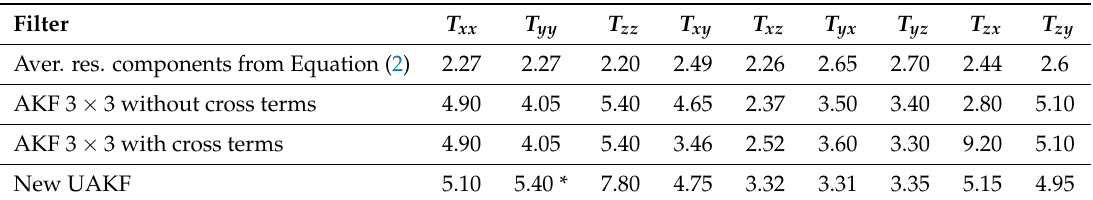
Table 1. Achieved frequency bandwidth in [kHz] by applying the different Kalman filters. *: due to coherence function decrease at that frequency. Filter Aver. res. components from Equation (2)